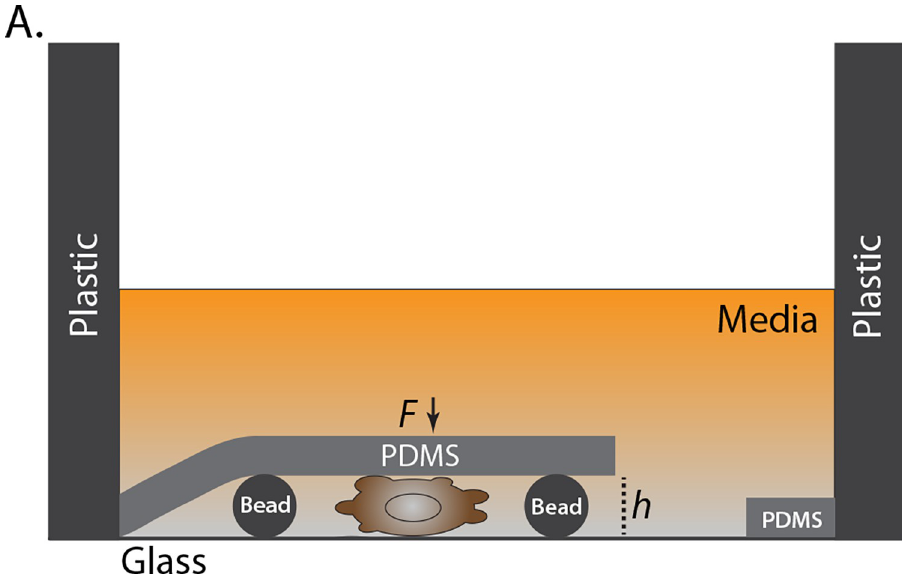
Fig 1. Schematic of the 2D confinement assay. A. The confinement height ( h ) is maintained by micron-sized beads. Downward force ( F ) onto the cells and beads comes from the attachment between the elastic PDMS and plastic wall of a glass-bottom well or tissue culture